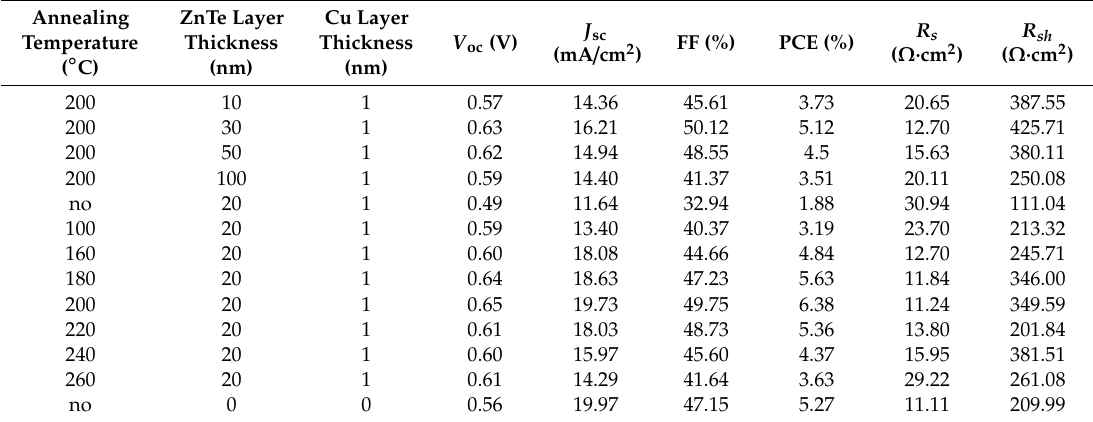
Figure 4. J–V curves of ITO / ZnO / CdSe / CdTe / ZnTe:Cu / Au and ITO / ZnO / CdSe / CdTe / Au ( a ) under light and ( b ) under dark conditions. Table 1. Summary of the photovoltaic parameters of the nanocrystal (NC) solar cells prepared under different conditions.